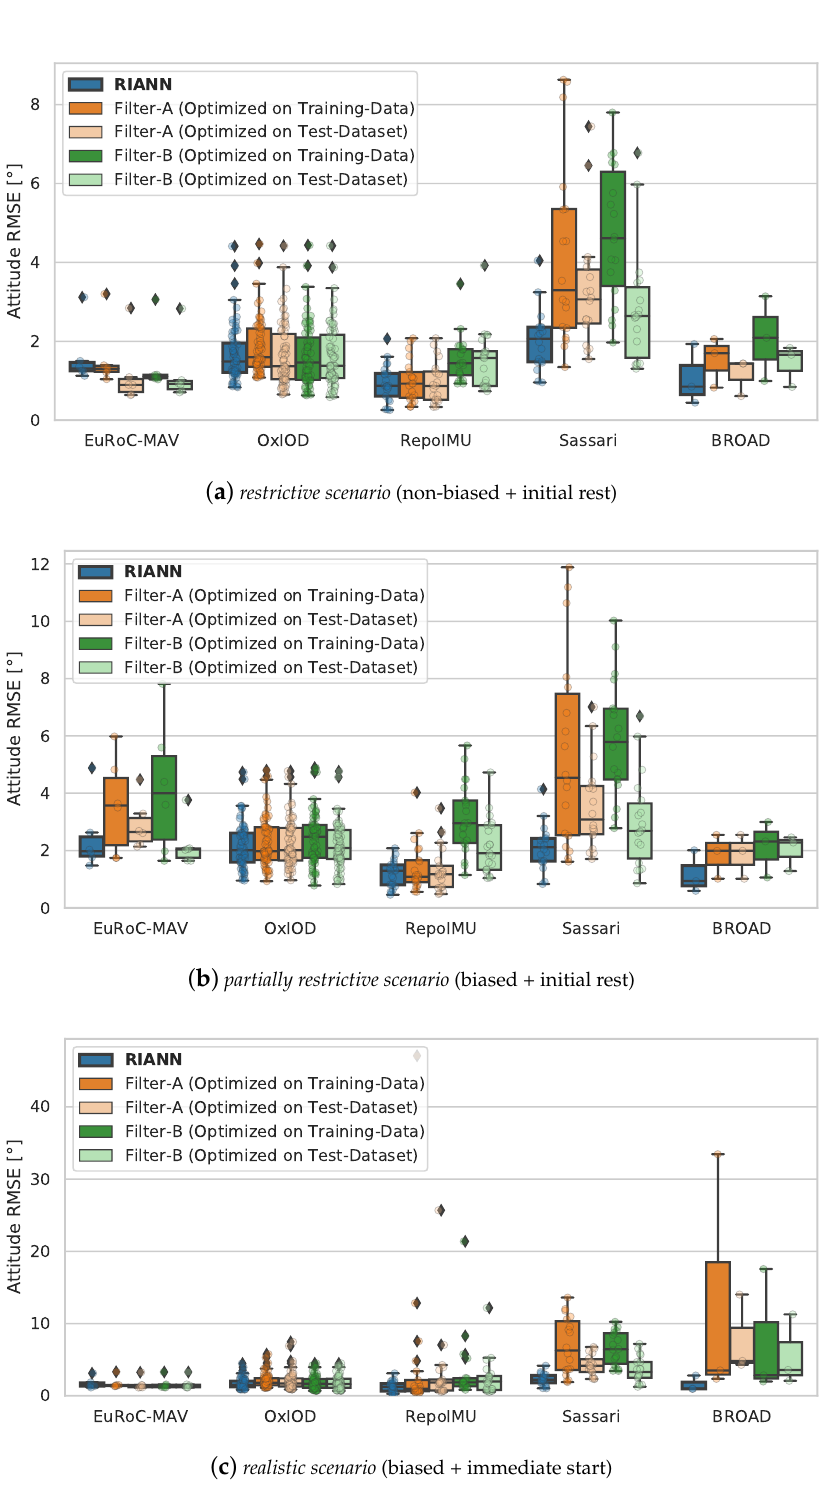
Figure 12. Comparison of RIANN with Filter-A and Filter-B, which are optimized either on the entire training data or on the specific test dataset. Across all scenarios and datasets, RIANN performs at least as good as the conventional filters and often outperforms them, especially in the realistic scenario and partially restrictive scenario